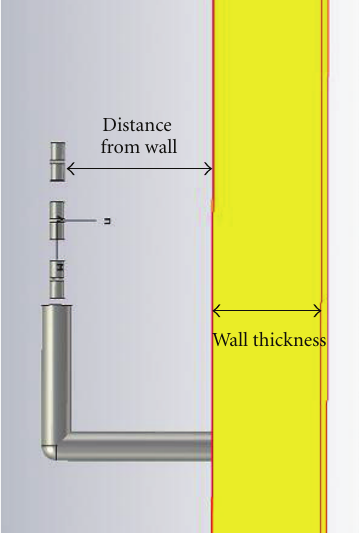
Figure 12: ISSDPG distribution for the patch-wall perpendicular case.